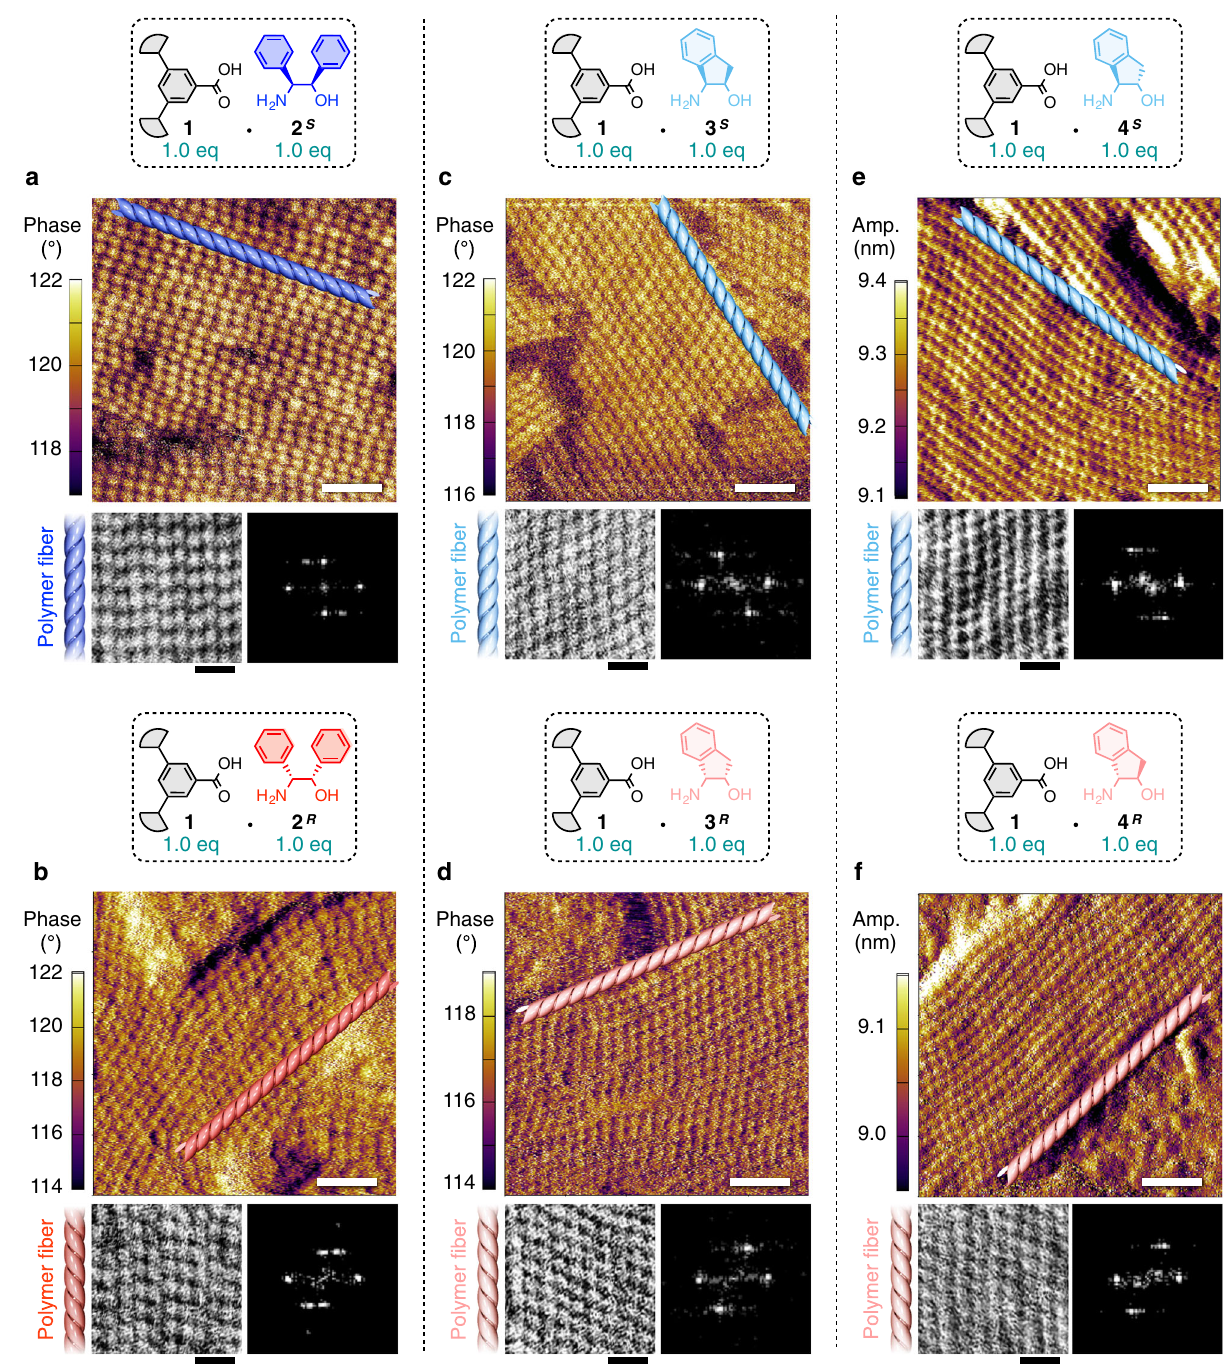
Fig. 4 Determination of the helical handedness of the supramolecular polymers. a – f AFM data of 1 ∙ 2 S ( a ), 1 ∙ 2 R ( b ), 1 ∙ 3 S ( c ), 1 ∙ 3 R ( d ), 1 ∙ 4 S ( e ), and 1 ∙ 4 R ( f ) spin-coated on HOPG substrates from dodecane solutions (4.0 mM). AFM phase/amplitude images (upper; scale bar, 20 nm), gray-scale images trimmed (38 × 38 nm) from the AFM images (lower left; scale bar, 10 nm), and magni fi ed FFT images of the gray-scale images (lower right). The illustrations of helices indicate the orientation direction of the supramolecular polymer fi bers. The corresponding AFM height images are shown in Supplementary Fig. 11. For details of FFT, see Supplementary Methods and Supplementary Fig.